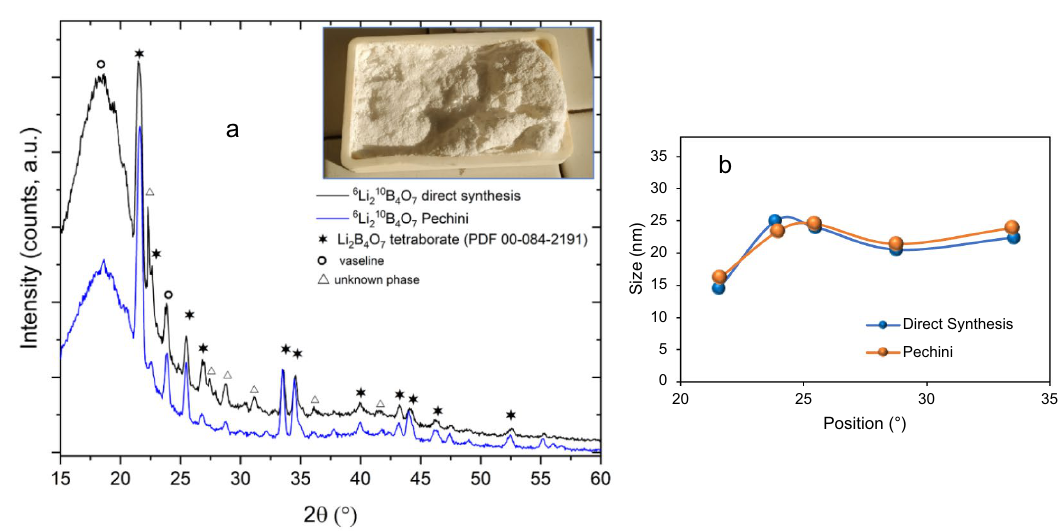
Figure 2. ( a ) XRD pattern of LiBO prepared by direct synthesis or Pechini method, showing the Li 2 B 4 O 7 phase assignment. The photo in the graph inset shows the powder extracted from the muffle furnace. ( b ) Crystallite size as derived from the Scherer formula is reported for both syntheses.